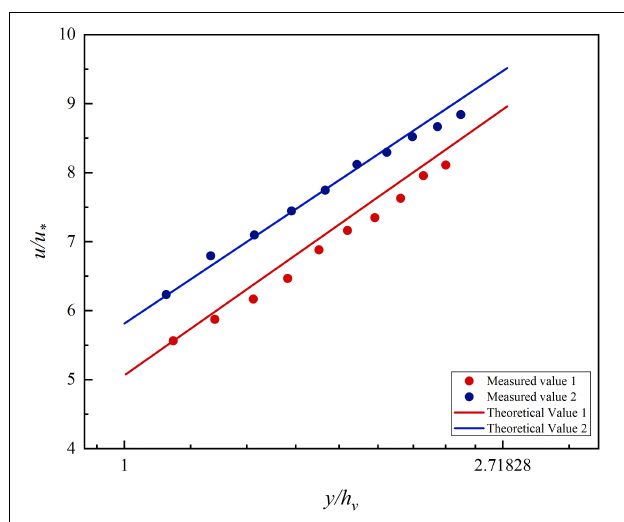
FIGURE 6 | Comparison of the velocity distribution of open channel with vegetation measured by Yang and the velocity distribution model of vegetation layer